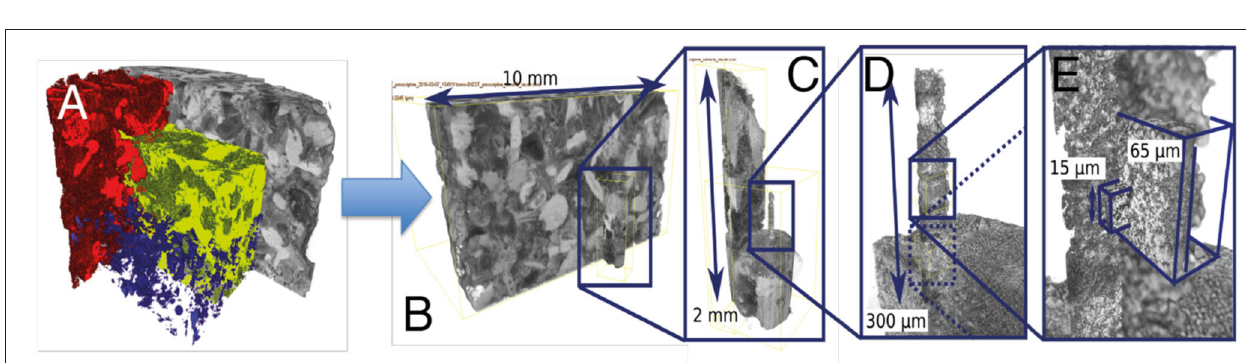
phase corresponds to its internal porosity distribution ( Figure 3 ). A 30 × 30 × 30 µ m region of microporosity (corresponding to 3 × 3 × 3 voxels within the macroscopic image) was then